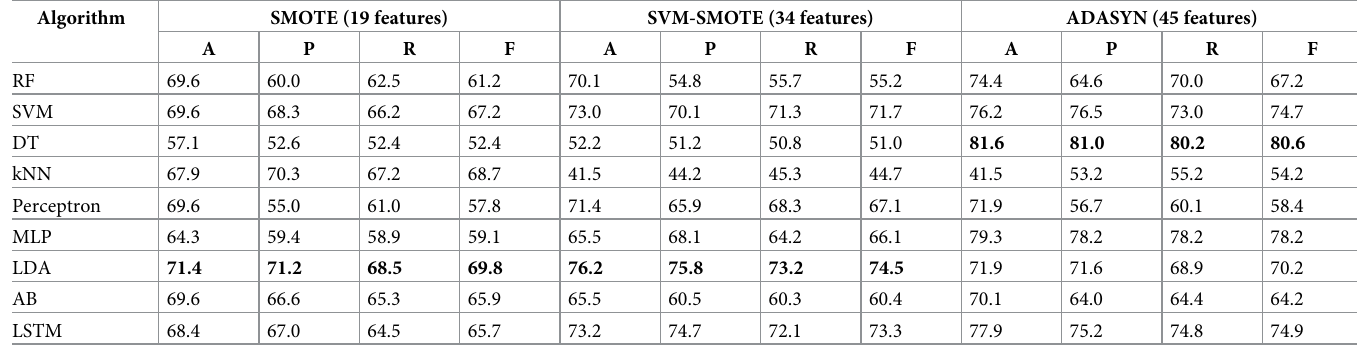
Table 5. Comparison of the effect of the three data augmentation methods on the algorithms with selected features (no. classes = 2). Algorithm SMOTE (19